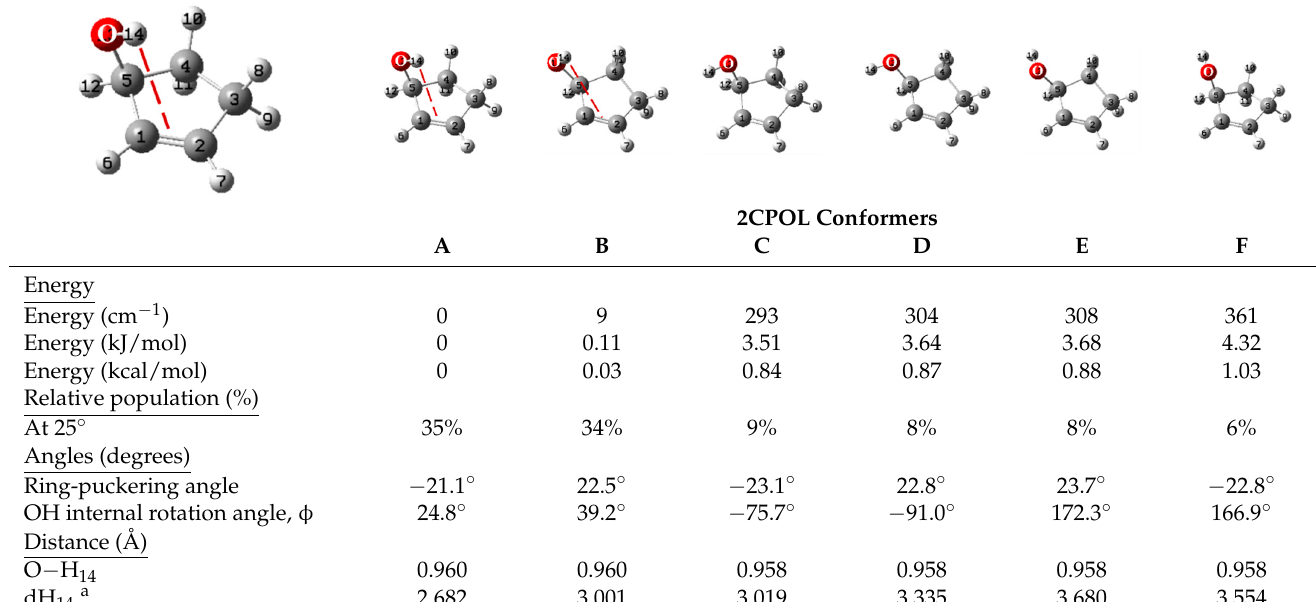
Table 1. Selected characteristics from CCSD/cc-pVTZ computations for all of the six 2CPOL conformers.